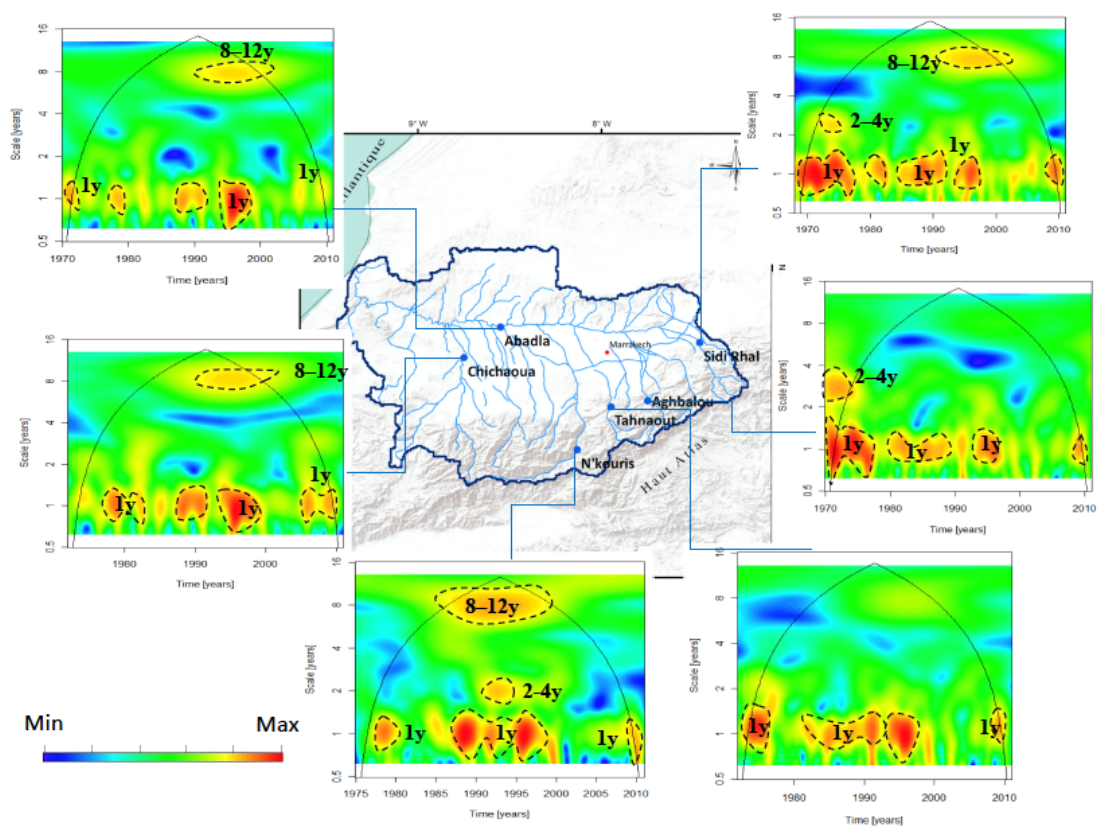
Figure 7. Spectra of continuous wavelet analysis of rainfall in the Sebou basin.